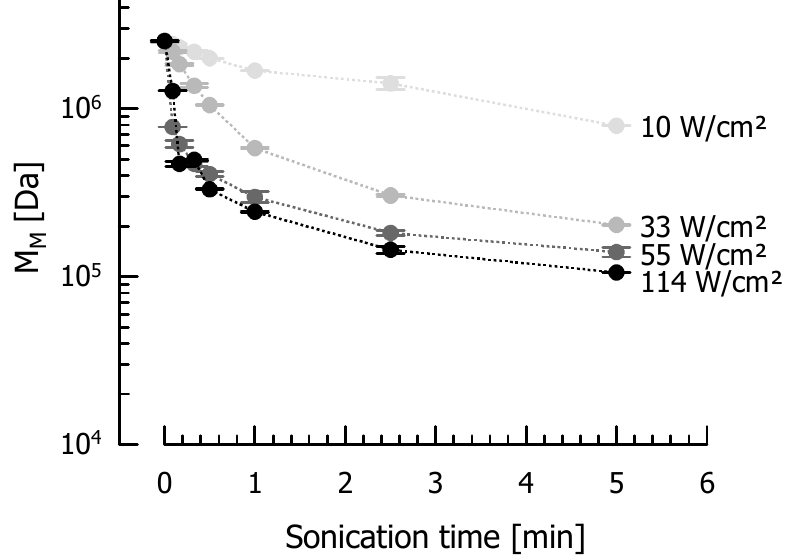
Figure 3. Weight average molecular mass M M [Da] of DGCC7710 fEPS after sonication of aqueous solutions (1.0 g/L) with an ultrasonic disintegrator at different power densities.